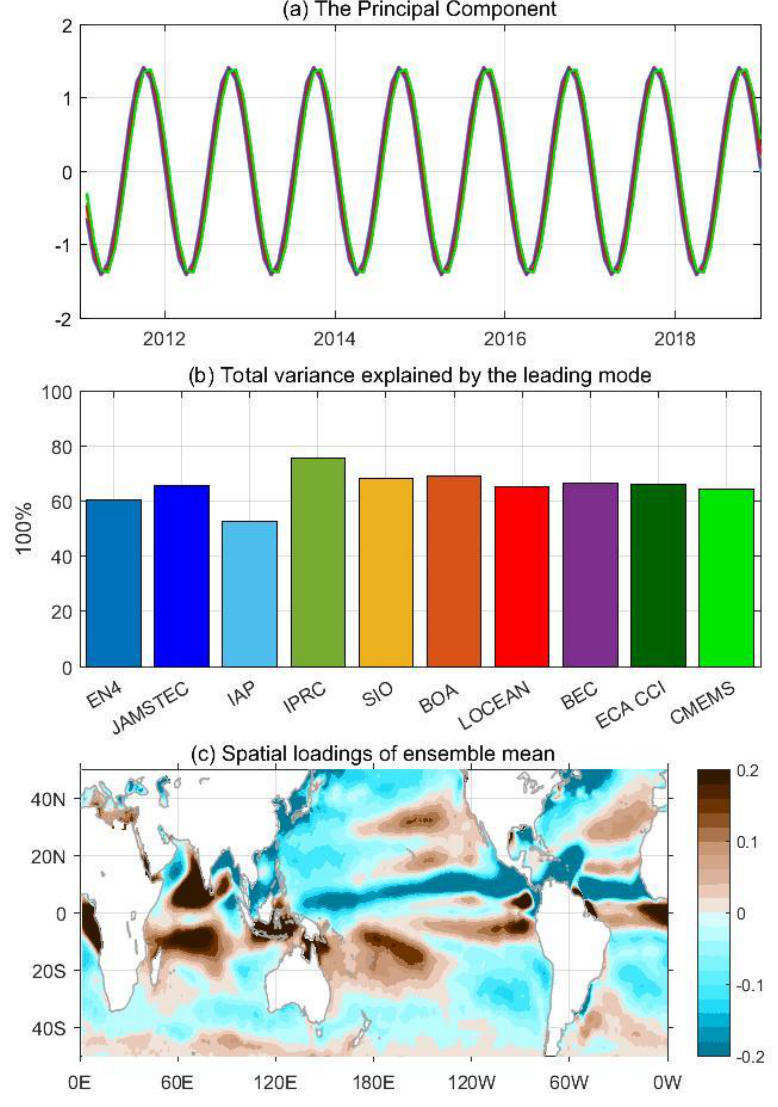
Figure 10. ( a ) The principal components for the annual SSS time series derived from individual product and ( b ) their contributions to the total variability in the annual SSS signal. The dark blue line/bar in ( a ) and ( b ) denotes EN4, blue represents JAMSTEC, light blue represents IAP, green represents IPRC, yellow represents SIO, orange represents BOA, red represents LOCEAN, purple represents BEC, dark green denotes ECA CCI and bright green denotes CMEMS. ( c ) The ensemble mean for the spatial loadings of the first EOF modes.